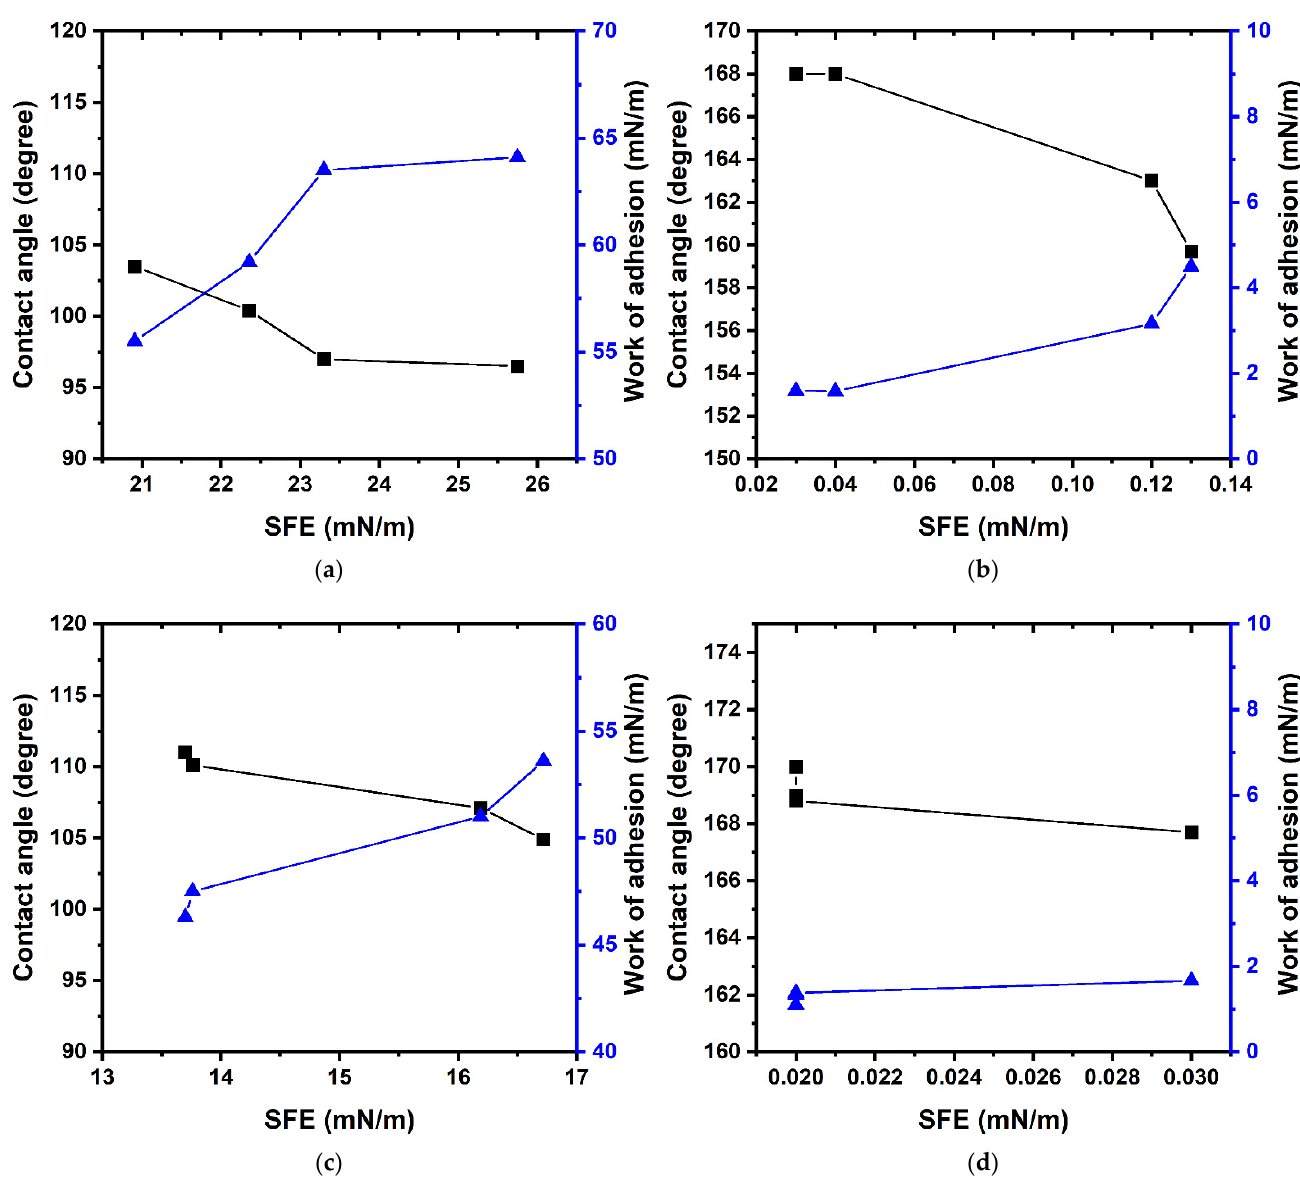
Figure 3. Dependence of the contact angle and the work of adhesion on the surface free energy for grafted coatings based on the poly-(TEMA-co-GMA) (( a )—glass; ( b )—textured aluminum) and poly-(HBMA-co-GMA) copolymers (( c )—glass; ( d )—textured aluminum).